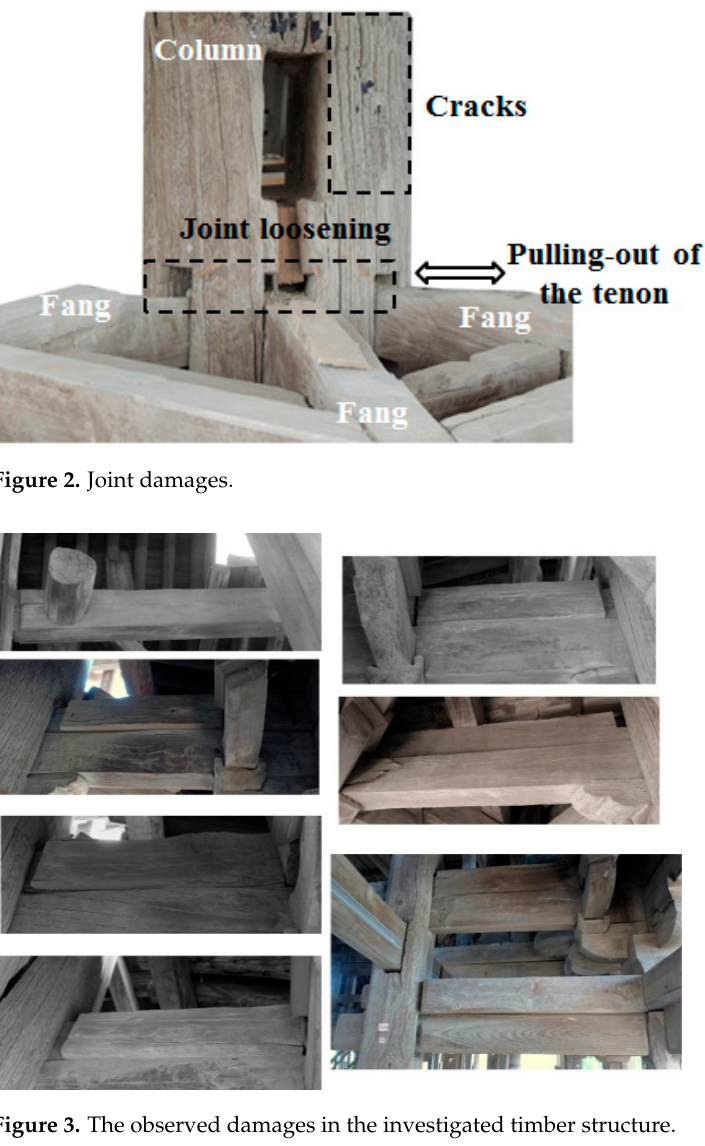
Figure 3. The observed damages in the investigated timber structure.